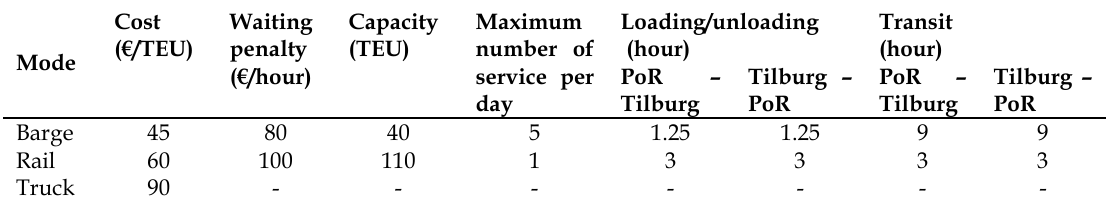
Table 1. Main assumptions in the illustrative